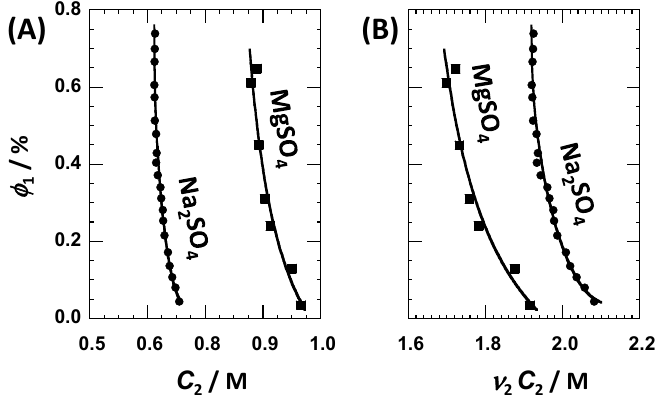
Figure 1. ( A ) Isothermal ( C 2 , φ 1 ) phase diagram, where C 2 is salt concentration, and φ 1 is surfactant volume fraction, showing the binodal phase boundary for the tyloxapol–MgSO 4 –water ( ■ ) and tyloxapol–Na 2 SO 4 –water ( • ) systems. Curves are eye guides. ( B ) Phase diagram in which salt osmolarity, ν 2 C 2 , replaces C 2 . Salt osmolarity needed to reach cloud point is lower in the MgSO 4 case than in the Na 2 SO 4 case, thereby showing that MgSO 4 is a stronger salting-out agent than Na 2 SO 4 .